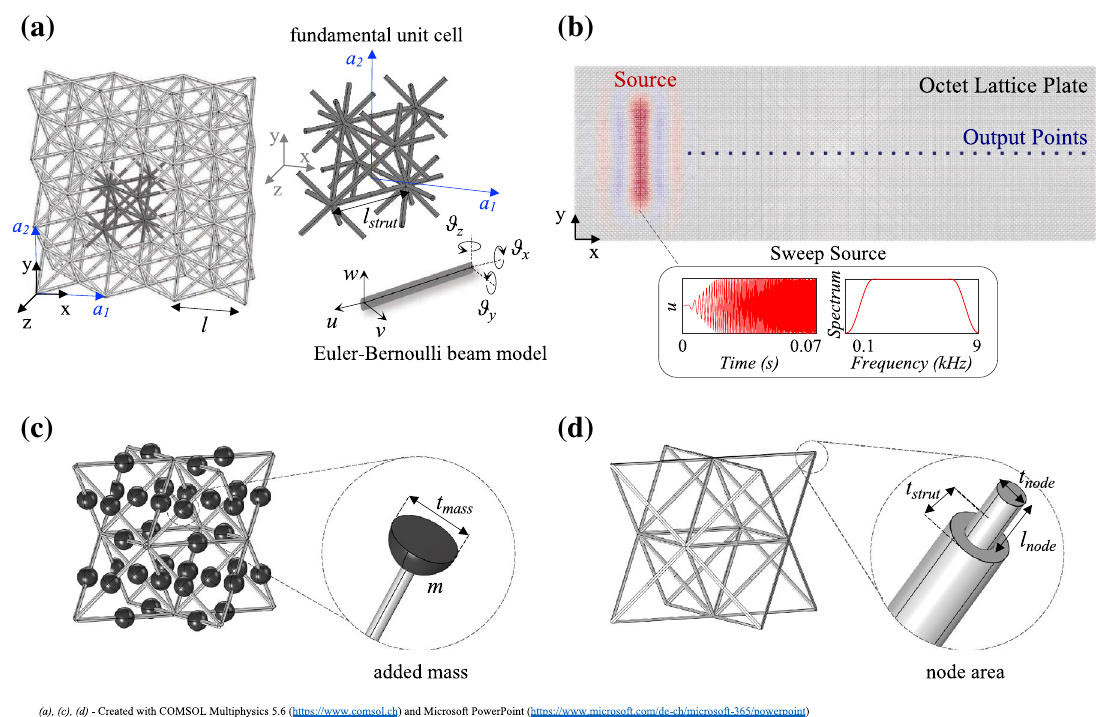
Figure 1. Cell designs and setups for dispersion and parametric analyses. ( a ) 2D standard octet lattice with fundamental unit cell depicted in the zoom ( a 1 = ( l , 0, 0) and a 2 = (0, l , 0)). ( b ) Finite lattice plate 1.2 0.03 m) for the validation of the band structure via time-transient simulations in Real-ESSI. The ( 3.6 × × constitutive unit corresponds to the standard octet reported in ( a ). The plane sweep source and line of points where the output signal is recorded, spaced 0.03 m apart and located on the nodes of the lattice, are marked in red and blue. ( c ) Customized octet equipped with spherical masses m , of diameter t mass , (dark color) added to the midpoint of the struts. ( d ) Octet with customized joints via tunable node thickness, t node . The zoomed plot inset shows the node area of length l node equal to 2 t strut and of variable thickness t node